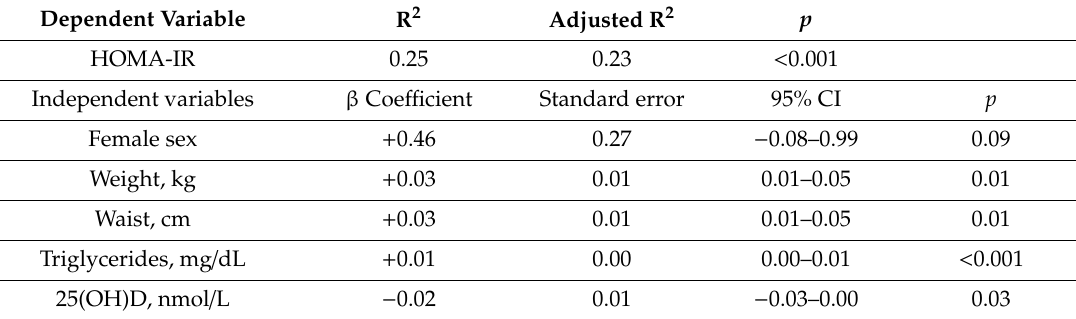
Table 3. Results for the stepwise multivariate linear regression model (n =